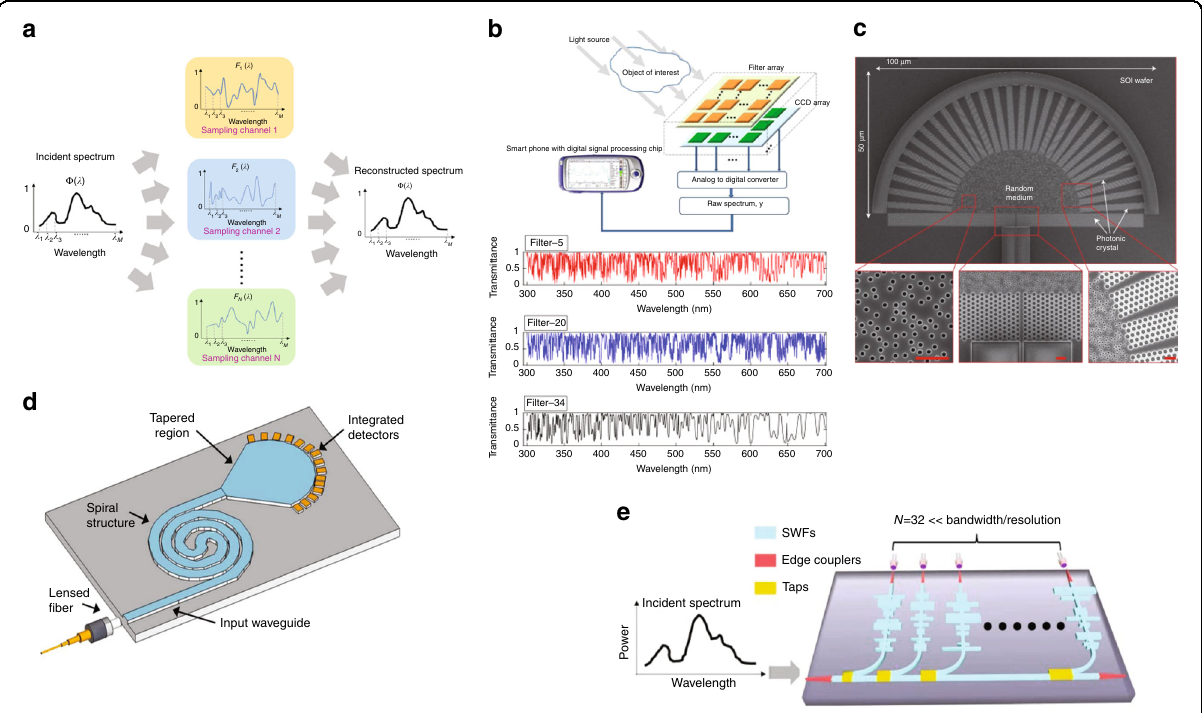
Fig. 11 Computational spectrometers on silicon photonics platform. a General schematic for computational spectrometers. b The fi rst demonstration of computational spectrometers 87 . c – e The recently demonstrated computational spectrometers on silicon photonics using disordered medium 13 , ultra-long multimode waveguide 96 and strati fi ed waveguide fi lters 20 , respectively. b Reprinted with permission from ref. 87 . © Optica Publishing Group. c Reprinted by permission from Springer Nature: Nature Photonics ref. 13 , 2013. d Reprinted with permission from ref. 96 . © Optica Publishing Group. e Reprinted by permission from Springer Nature: Nature Communications ref. 20 ,